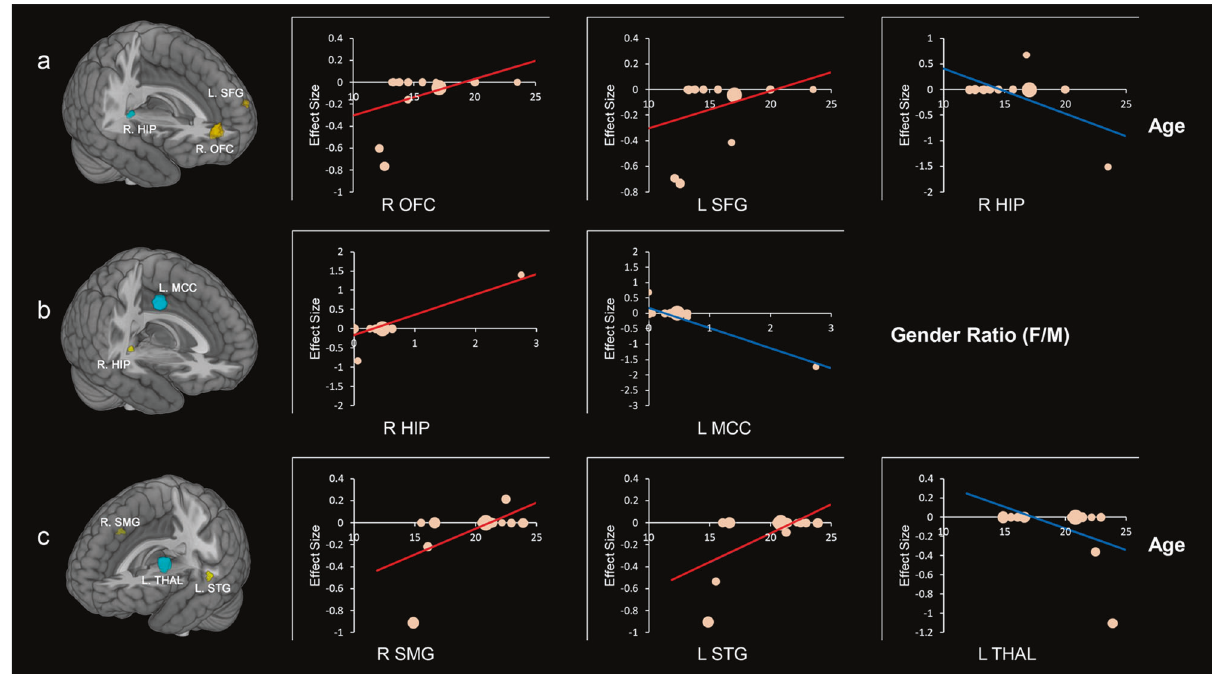
Fig. 4 Results of meta-regression analyses. a Brain regions where the associations of attention de fi cit/hyperactivity disorder (ADHD) with GMV were modulated by age. b Brain regions where the associations of ADHD with GMV were modulated by sex (female ratio). c Brain regions where the associations of substance use disorders with GMV were modulated by age. Clusters were displayed at p < 0.0005 and cluster size > 10 voxels. Positive correlation was shown in orange with an upward regression line while negative patterns in blue with a downward line. In the plot, each study is marked as a dot, and the size of each dot corresponds to the sample size. L Left, R Right, SFG Superior frontal gyrus, HIP Hippocampus, OFC Orbitofrontal cortex, MCC Median cingulate gyrus, SMG Supramarginal gyrus, STG Superior temporal gyrus, THAL Thalamus, F/M